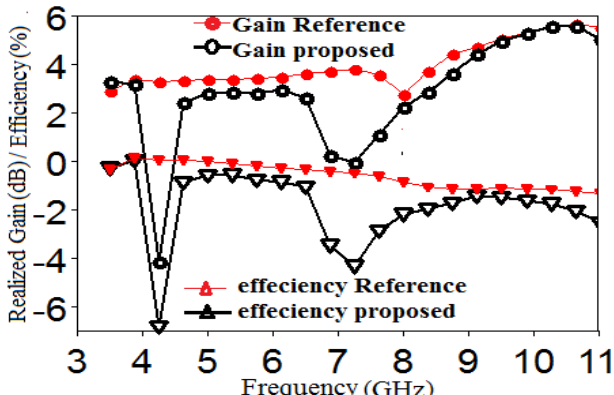
Figure 13: The simulated gain and efficiency values of the reference and modified dual notched UWB antenna.